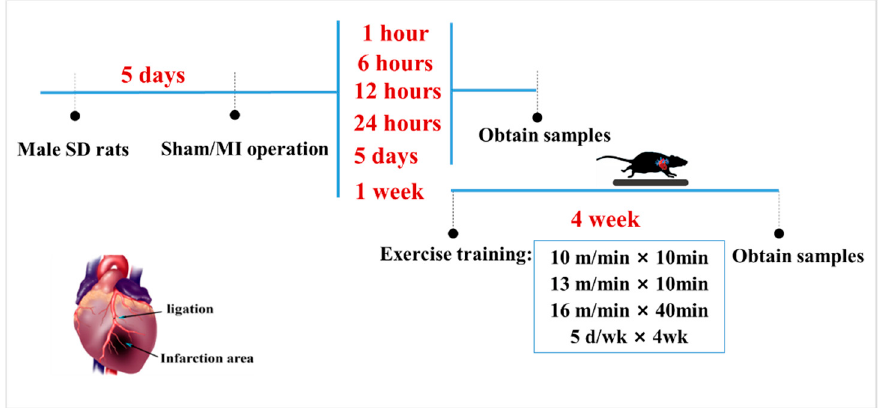
Figure 1. Schematic diagram of the animal experimental design and protocol. One week after the operation, male Sprague-Dawley rats in the MI + EX group and EX group were subjected to exercise on a motorized rodent treadmill for 4 weeks. All rats were euthanized for cardiac tissue and serum sample collection after a 4-week exercise protocol.